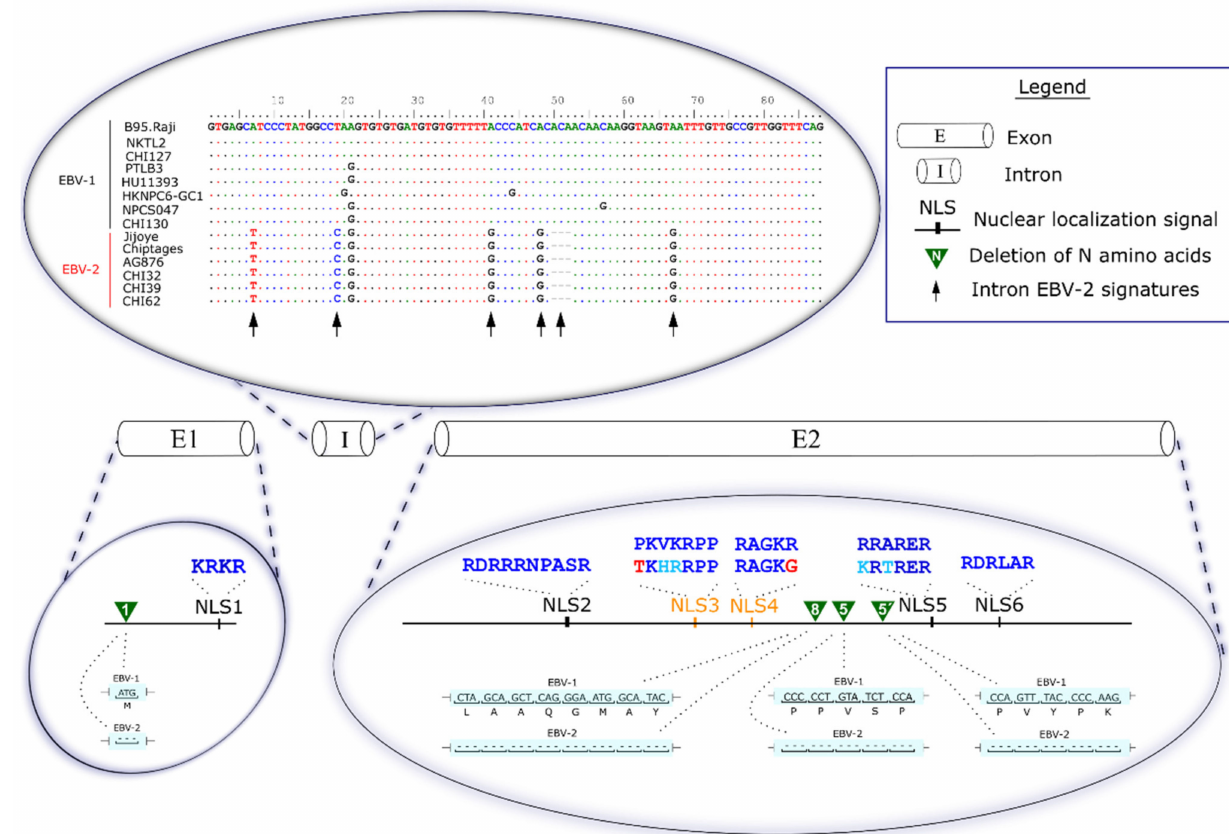
Figure 2. Schematic representation of EBNA3A amino acid architecture. Coding (exons E1 and E2) and non-coding (intron I) regions of EBNA3A are in the center of the image. The intron region’s upper zoom area shows the five unique nucleotides and three-nucleotide deletions (arrows) shared only with the EBV-2 sequences. At the bottom of the image are the EBNA3A nuclear location signals (NLSs), with the respective canonical amino acids of each of the six motifs in dark blue. Non-canonical NLSs with crucial changes are highlighted in orange (NLS3 and NLS4). The amino acid changes that would not directly affect the non-canonical motifs are in light blue. The amino acid changes that would directly affect the non-canonical motifs are highlighted in red. The green triangle indicates the four EBV-2-typical deletions identified in this study, and the amino acid deletions are highlighted with a light blue background. The numbers inside the triangles (1, 8, 5, and 5 (cid:48) ) indicate the number of amino acids deleted. There were two deletions of five amino acids: the first deletion is indicated with the number 5, and the second with 5 (cid:48)